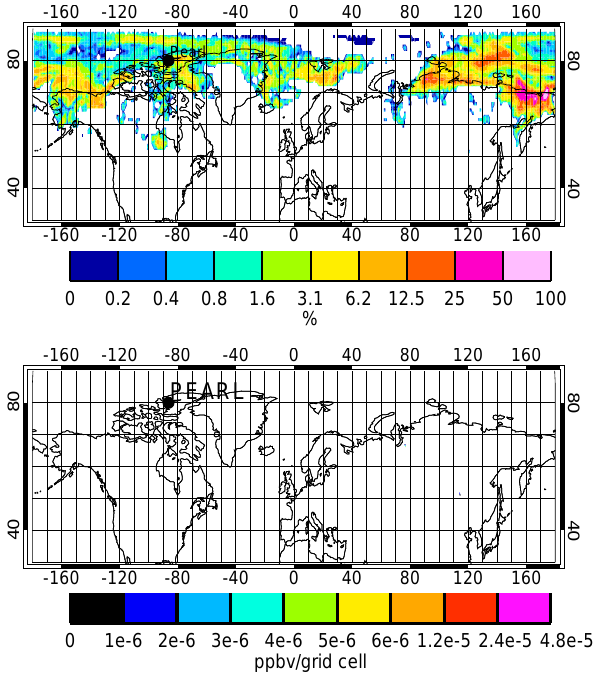
Fig. 10. Similar to Fig. 9 but for particles arriving at the receptor from 30 August 2006, 00:00UTC to 31 August 2006, 00:00UTC. Maximum residence time: